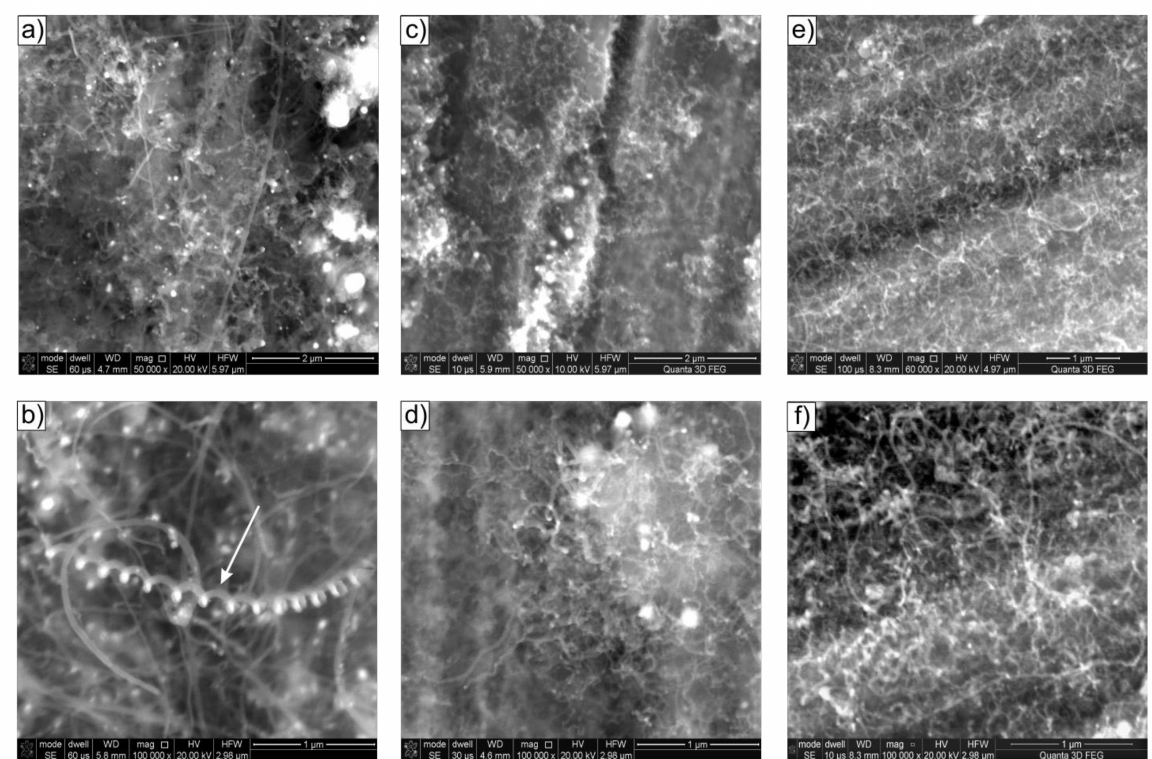
Figure 3. SEM morphology of Ni 3 Al foils’ surface after decomposition of ethanol with addition of 0.35 vol.%. water steam